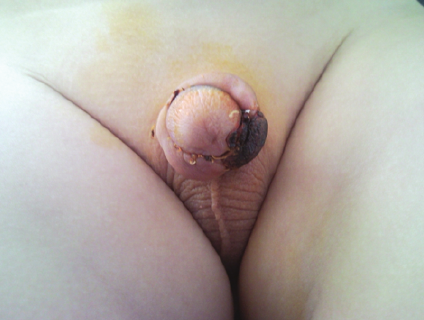
Figure 1: Patient in whom ventral penile skin defect was covered with Byars’ flap and superficial necrosis developed.